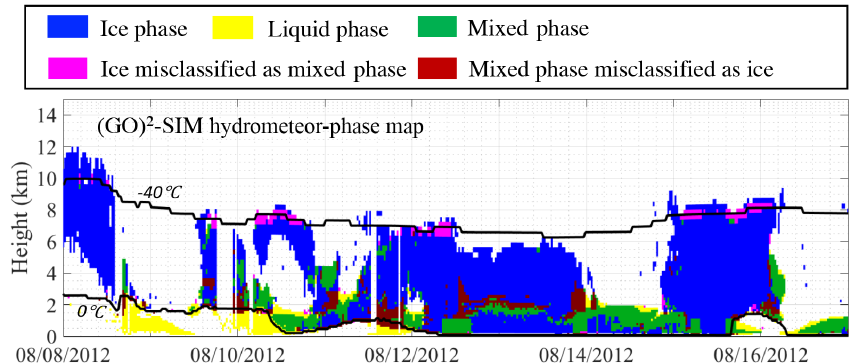
Figure 8. Example output from (GO) 2 -SIM phase-classification algorithms (using objectively determined thresholds and one set of empirical relationships in the forward simulator). The locations of ice-phase hydrometeors (blue), liquid-phase hydrometeors (yellow), and mixed- phase hydrometeors (green) are illustrated. After evaluation against the original ModelE output mixing ratios, we found that some mixed- phase hydrometeors were misclassified as ice phase (red) and some ice-phase hydrometeors were misclassified as mixed phase (magenta). Also indicated are the locations of the 0 and − 40 ◦ C isotherms (black